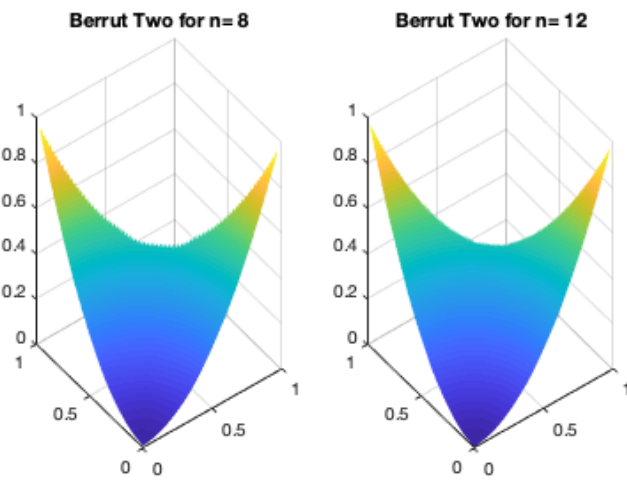
Figure 11. Berrut Two for n a multiple of